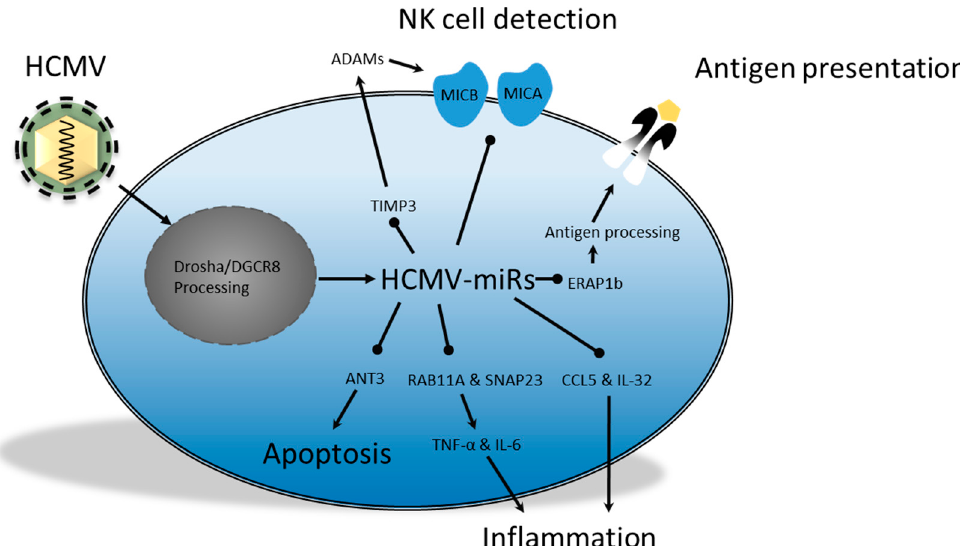
Figure 4. HCMV-encoded miRs downregulate targets that are involved in modulating the production and secretion of pro-inflammatory cytokines. In addition, these vmiRs can promote MICA/B shedding by reducing the negative regulator TIMP3, which results in decreased NK cell detection. Detection of HCMV-infected cells by CTLs can also be decreased due to mitigated antigen processing as a result of reduced ERAP1. TIMP3, MICA/B, ANT3, IL-32 and CCL5 targets were determined using reporter assays, while RAB11A and SNAP23 targets were determined using RIP-CHIP and the ERAP1b target was determined using RISC immunoprecipitation. ADAMs, a disintegrin and metalloprotease; TIMP3, tissue inhibitors of metalloproteinase 3; ANT3, adenine nucleotide translocator 3; RAB11A, RAS-related protein 11A; SNAP23, synaptosomal-associated protein 23; ERAP1b, endoplasmic reticulum aminopeptidase 1b.